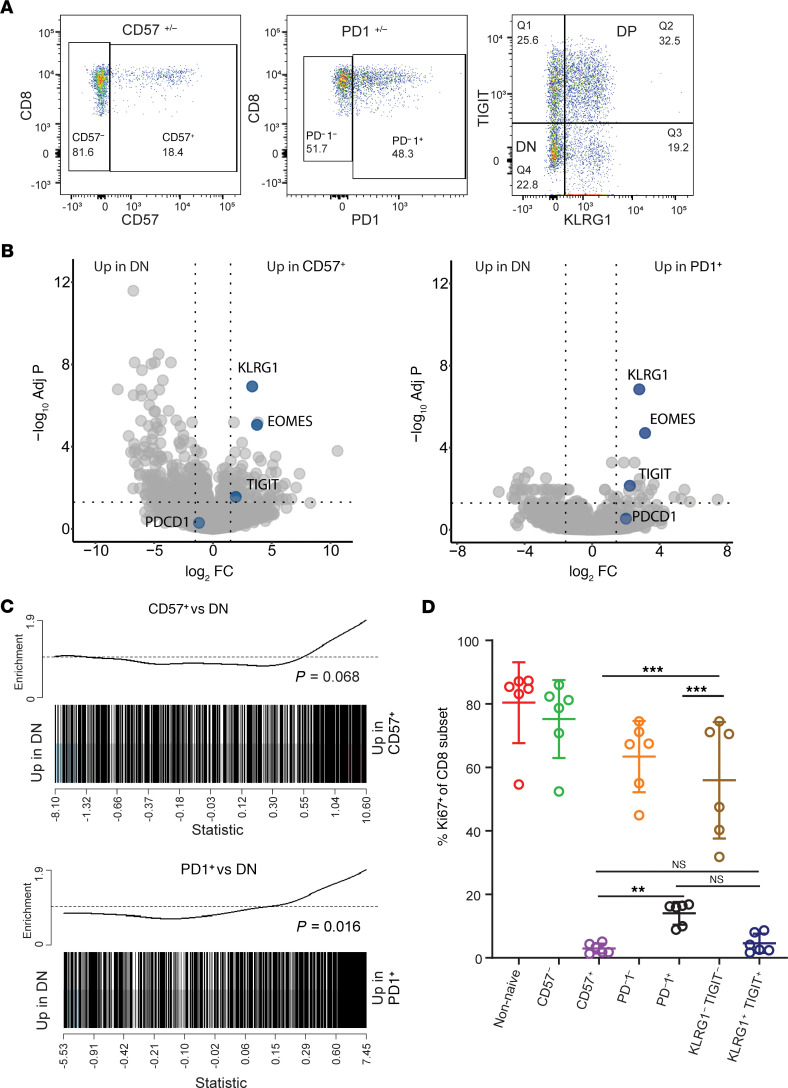
CD57+ and PD-1+ response-associated CD8+ T cells were hypoproliferative and expressed features of exhaustion.(A) Representative plots illustrate sorting strategy to isolate memory (nonnaive CD8 excluding CD45RA+CCR7+) CD8+ T cell populations (CD57+/–, PD-1+/–, and KLRG1/TIGIT+/–). (B) Volcano plots show differentially expressed genes contrasting PD-1+ (right) and CD57+ (left) with DN cells. Genes canonically associated with exhaustion, as well as key markers of clusters 12 and 20, are highlighted and labeled. (C) Enrichment barcode plots contrast CD57+ and PD-1+ populations with KLRG1/TIGIT–double negative cells in their expression of blue module genes. P value from rotation gene set analysis roast in R. (D) Ki67+ cell frequency in each of the sorted CD8 subsets (week 104 samples; n = 6) following 4 days of stimulation with plate-bound anti-CD3/soluble anti-CD28. Data are presented as mean ± SEM. P values were calculated using 1-way ANOVA, and results are displayed for comparisons of CD57+, PD-1+, and KLRG1–TIGIT– (DN) frequencies. *P < 0.01, ***P < 0.001.